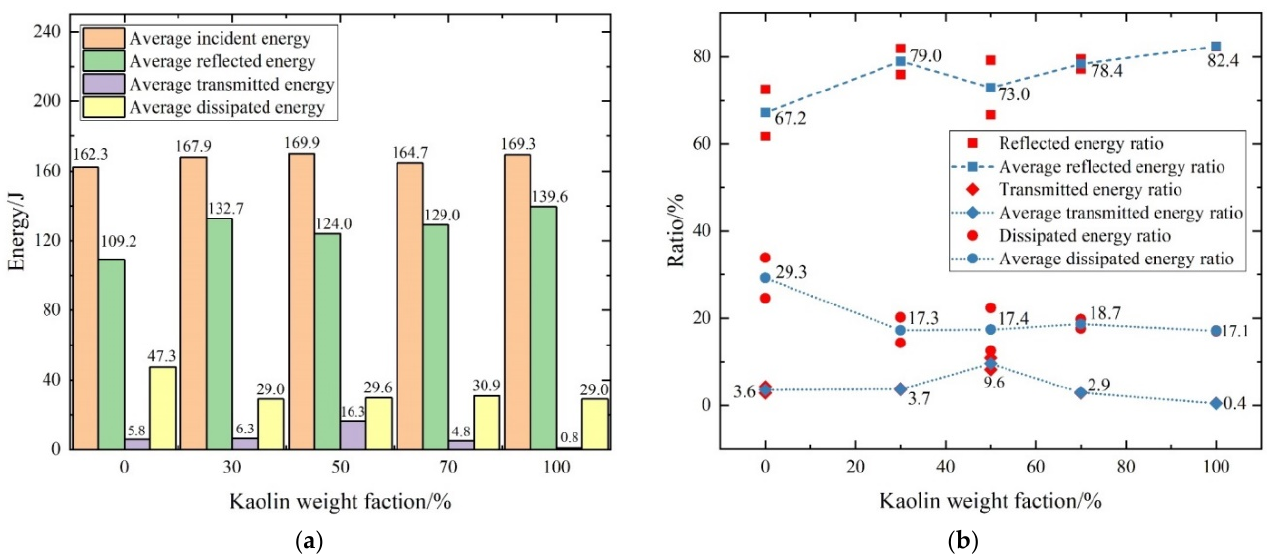
Figure 9. ( a ) Energy distribution histogram of specimens with different Kaolin weight fractions after impact. ( b ) Ratio curve of each part energy to incident energy. impact. ( b ) Ratio curve of each part energy to incident